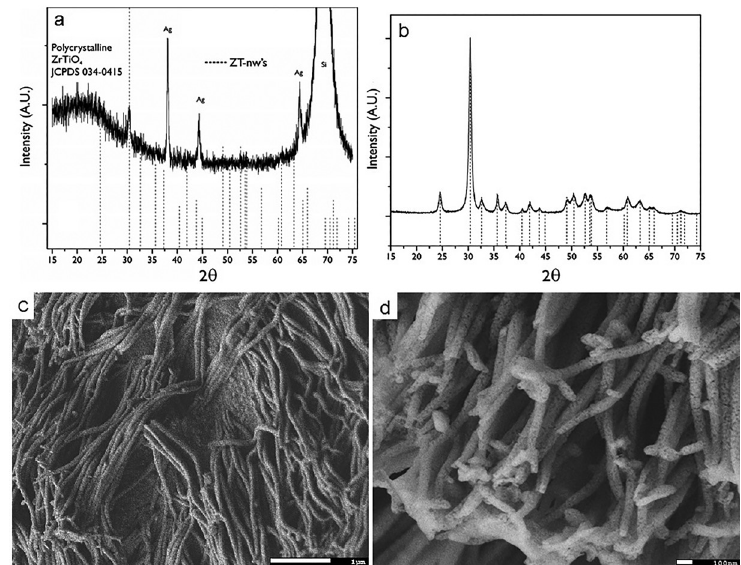
Figure 7. DRX patterns of (a) ZrTiO 4 nanowires on substrate; (b) ZrTiO 4 powder obtained from thermal treatment at 700 °C; (c) and (d) shows the FESEM images of the ZrTiO 4 nanowires.